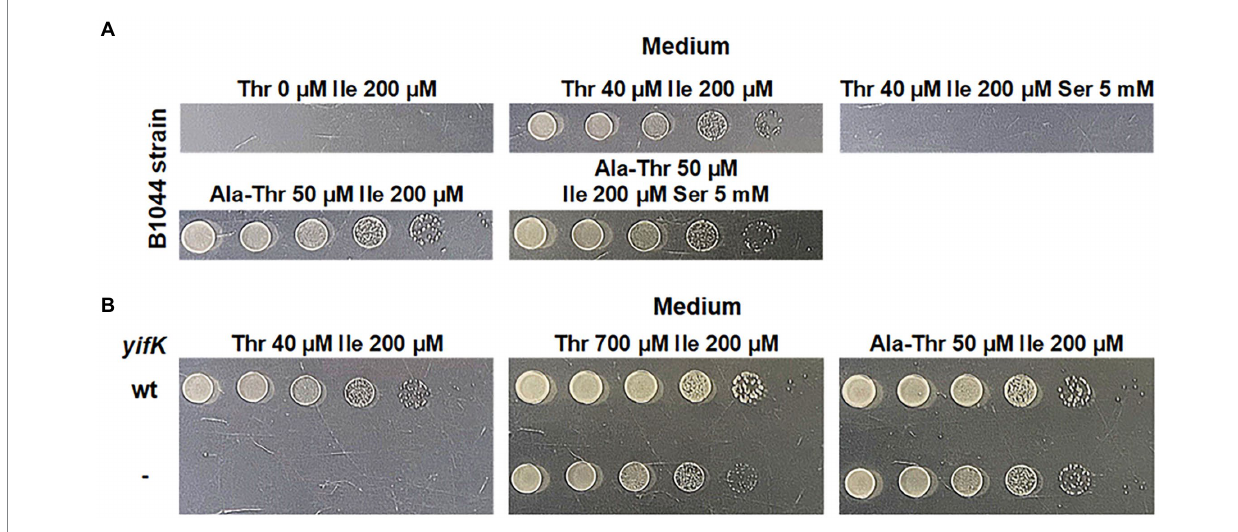
FIGURE 1 Phenotype assay of the threonine-auxotrophic B1044 strain and its yifK - derivative, B1082. The assay was performed using M9 minimal medium with 0.2% glucose and the indicated additives as described under “Phenotype assay” in the Materials and Methods. “Thr,” “Ile,” “Ser,” and “Ala-Thr” stand for L-threonine, L-isoleucine, L-serine, and L-alanyl-L-threonine, respectively. (A) Growth assay of B1044 on minimal plates with either L-threonine or L-alanyl-L-threonine as the L-threonine source. L-isoleucine was added to the medium as B1044 is unable to synthesize this amino acid along with